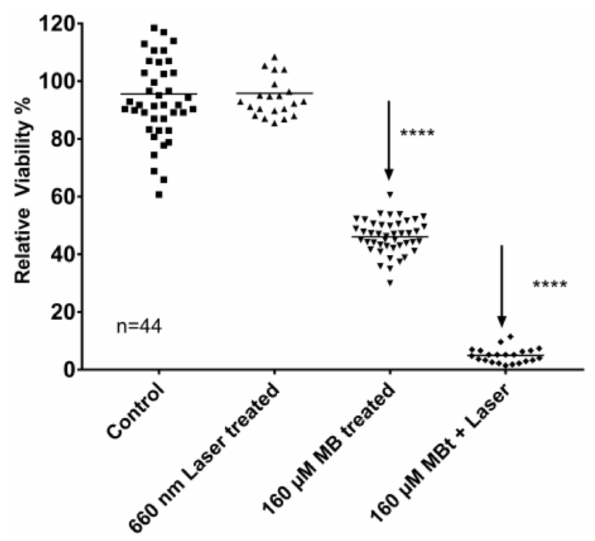
Figure 3. Toxic effects of 160 µ M 4 min MB and 8 min laser exposure on Detroit 562 cells. Laser exposure alone ensured 95.8% ± 2.2% cell viability, which was not significantly different from